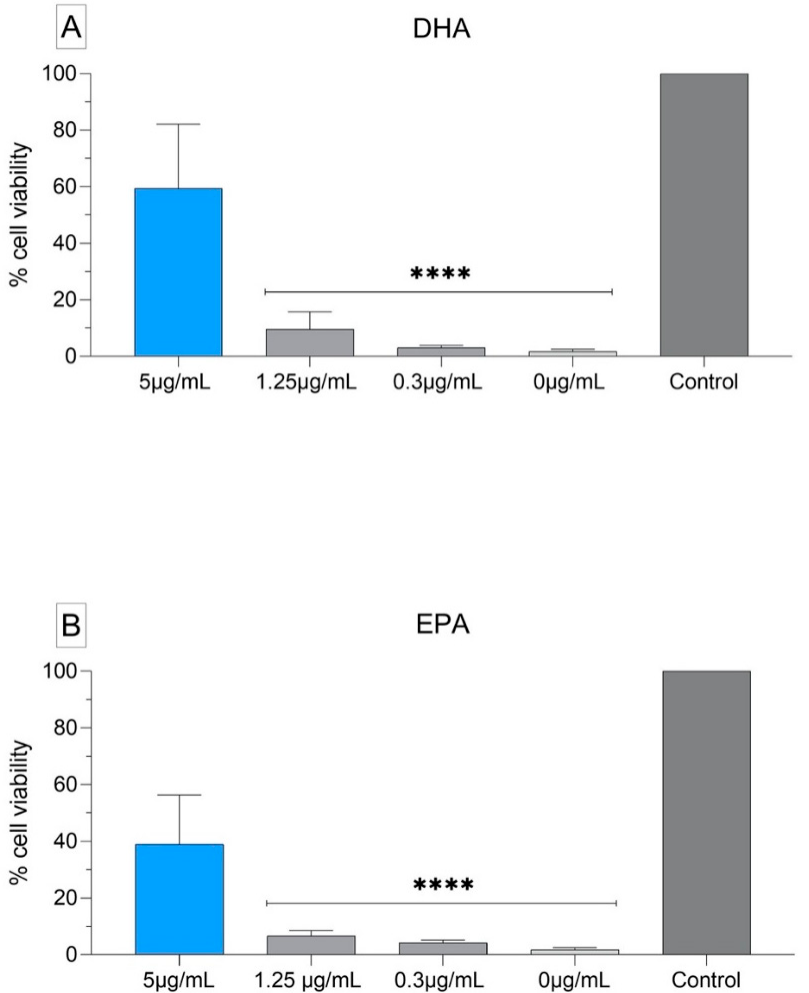
Figure 6. Cytotoxicity assay of EPA and DHA using human gingival fibroblasts HGF-1. The data are stated as mean ± SEM. ( A ) EPA; ( B ) DHA. The data obtained from the viability tests were analyzed using ordinary one-way ANOVA and Turkey’s multiple comparisons test ( **** p < 0.0001). The tests were made in duplicate.